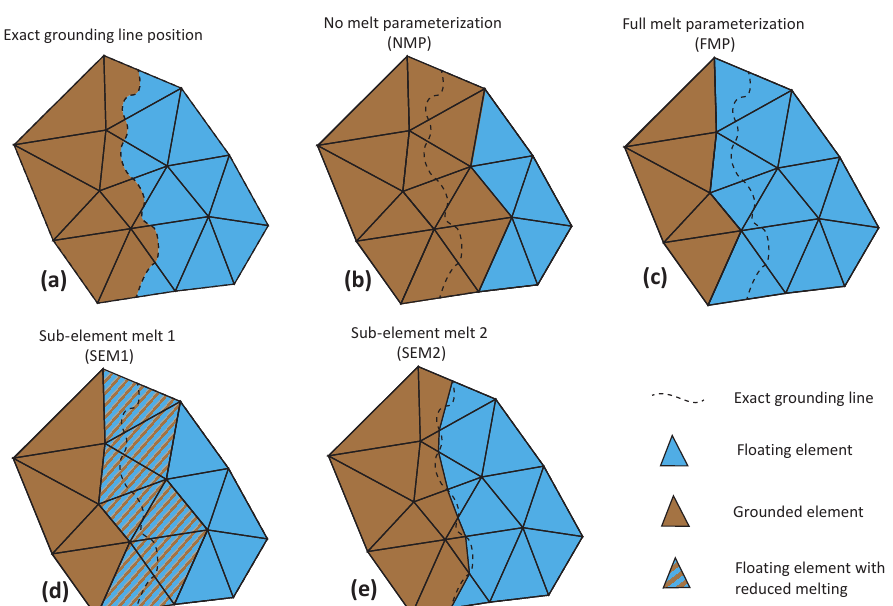
Figure 2. Grounding line discretization. Grounding line’s exact location (a) , no-melt parameterization (NMP, b ), full-melt parameterization (FMP, c ), sub-element melt 1 (SEM1, d ), and sub-element melt 2 (SEM2, e